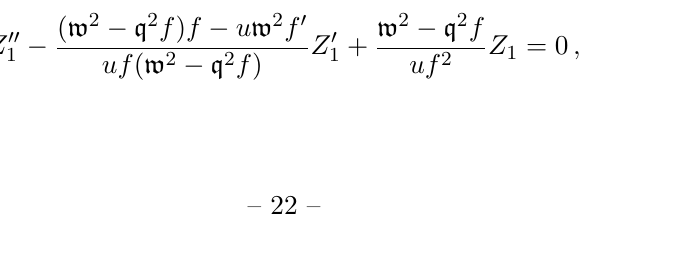
Figure 6 . Approximations to the position of the critical point in the complex q 2 shear channel of the N = 4 SYM theory arising from the order k hydrodynamic polynomials F k ( q 2 ; w ) = 0 (circles for k = 2, triangles for k = 3, squares for k = 4). The \exact"